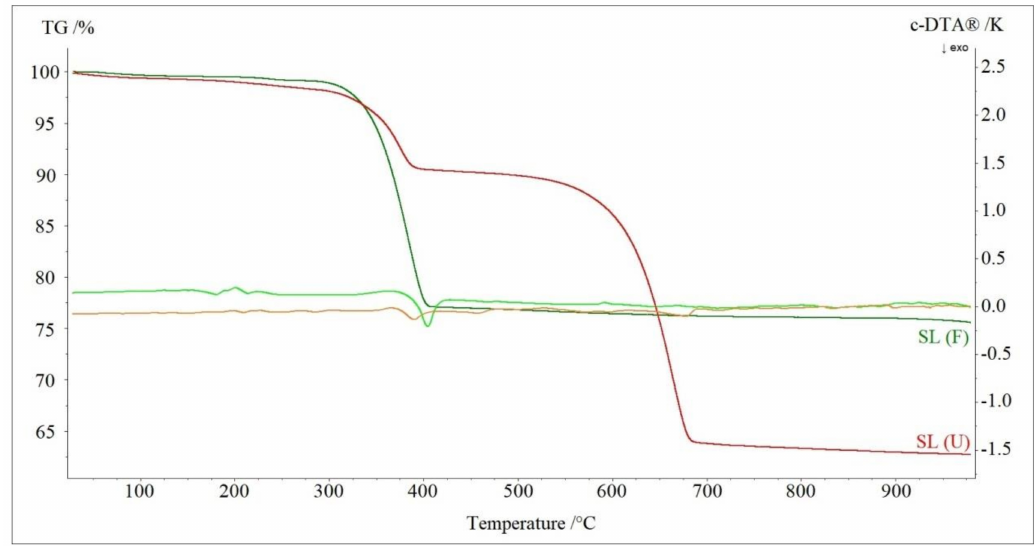
Figure 3. TG-DTA curves of decomposition of fresh soda lime sample (SL (F)) and used soda lime sample (SL (U)) in nitrogen.